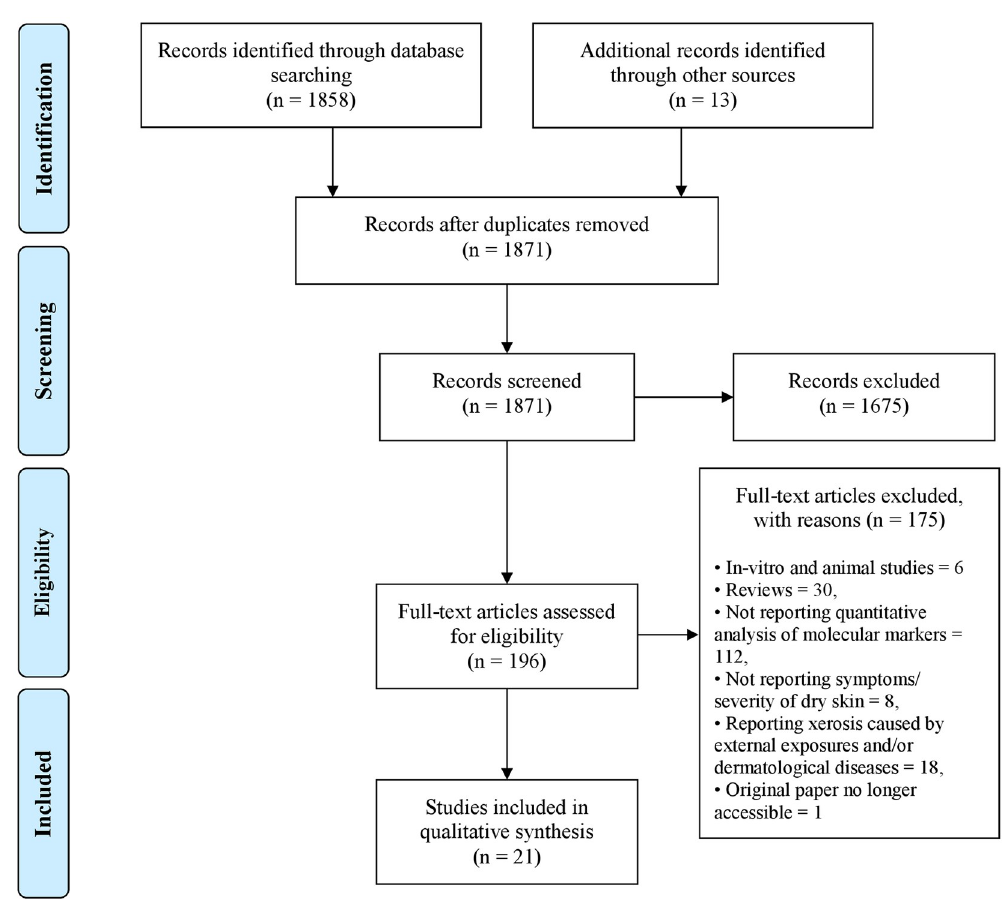
Fig 1. Flow diagram of the literature search and study selection